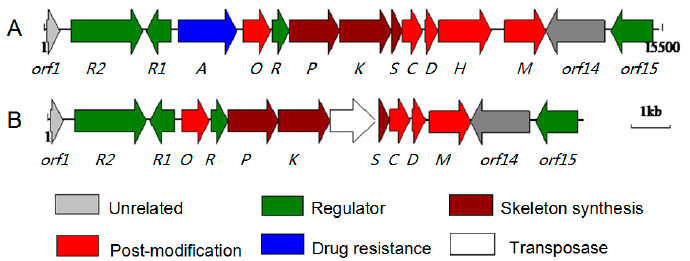
Figure 2. Organization of the ABX clusters from Streptomyces sp. FJS 31-2 ( A ) and Streptomyces sp. FXJ 1.264 ( B ).